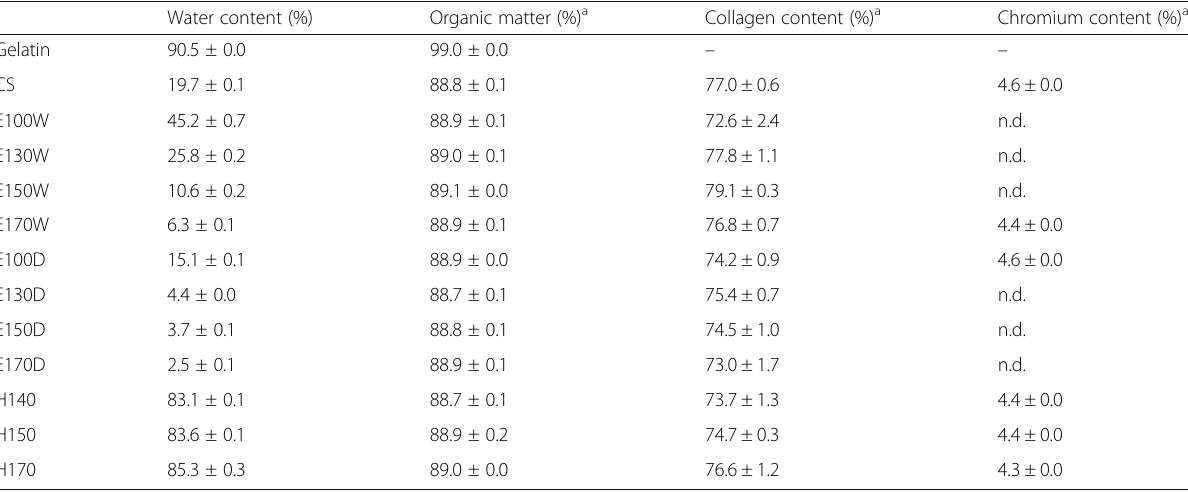
Table 2 Characterization of the pre-treated and untreated samples Water content